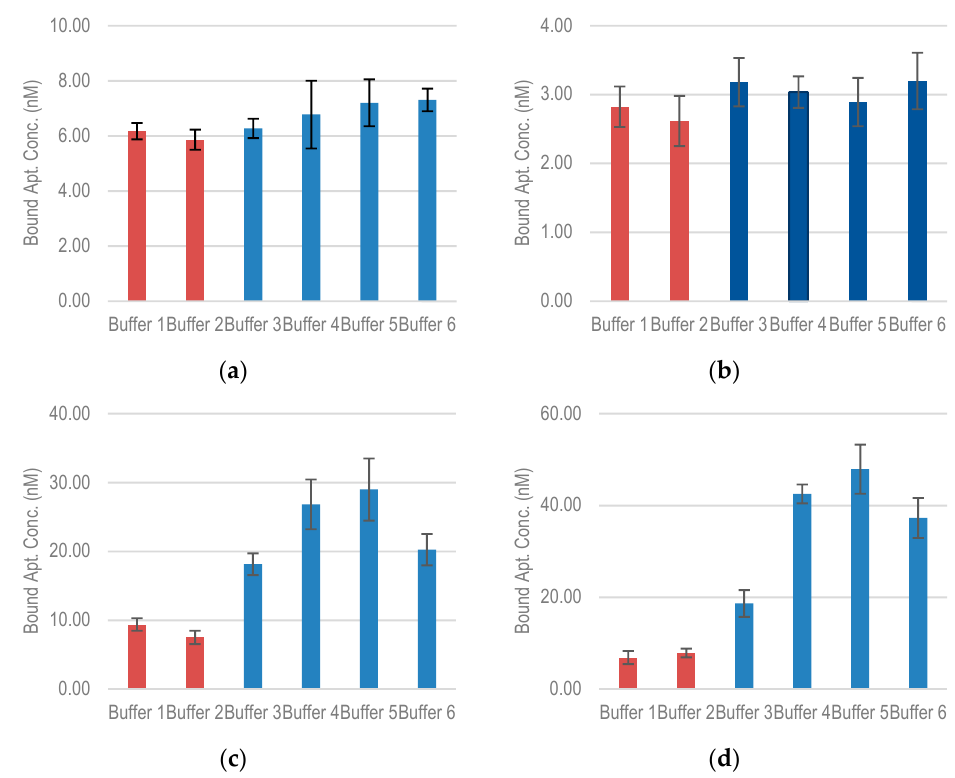
Figure 6. Bound aptamer concentration for ( a ) S1 ( b ) EcoR1 ( c ) E17F ( d ) E18R with E. coli O157:H7 in buffers of different ionic compositions (incubated aptamer concentration was fixed at 500 nM).